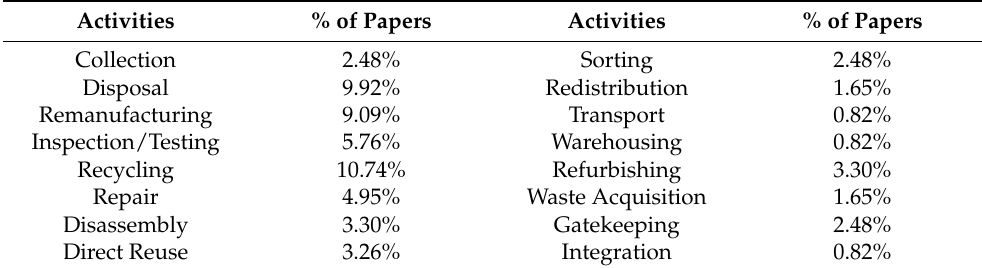
Table 4. Percentage of articles in the survey which defined RL process